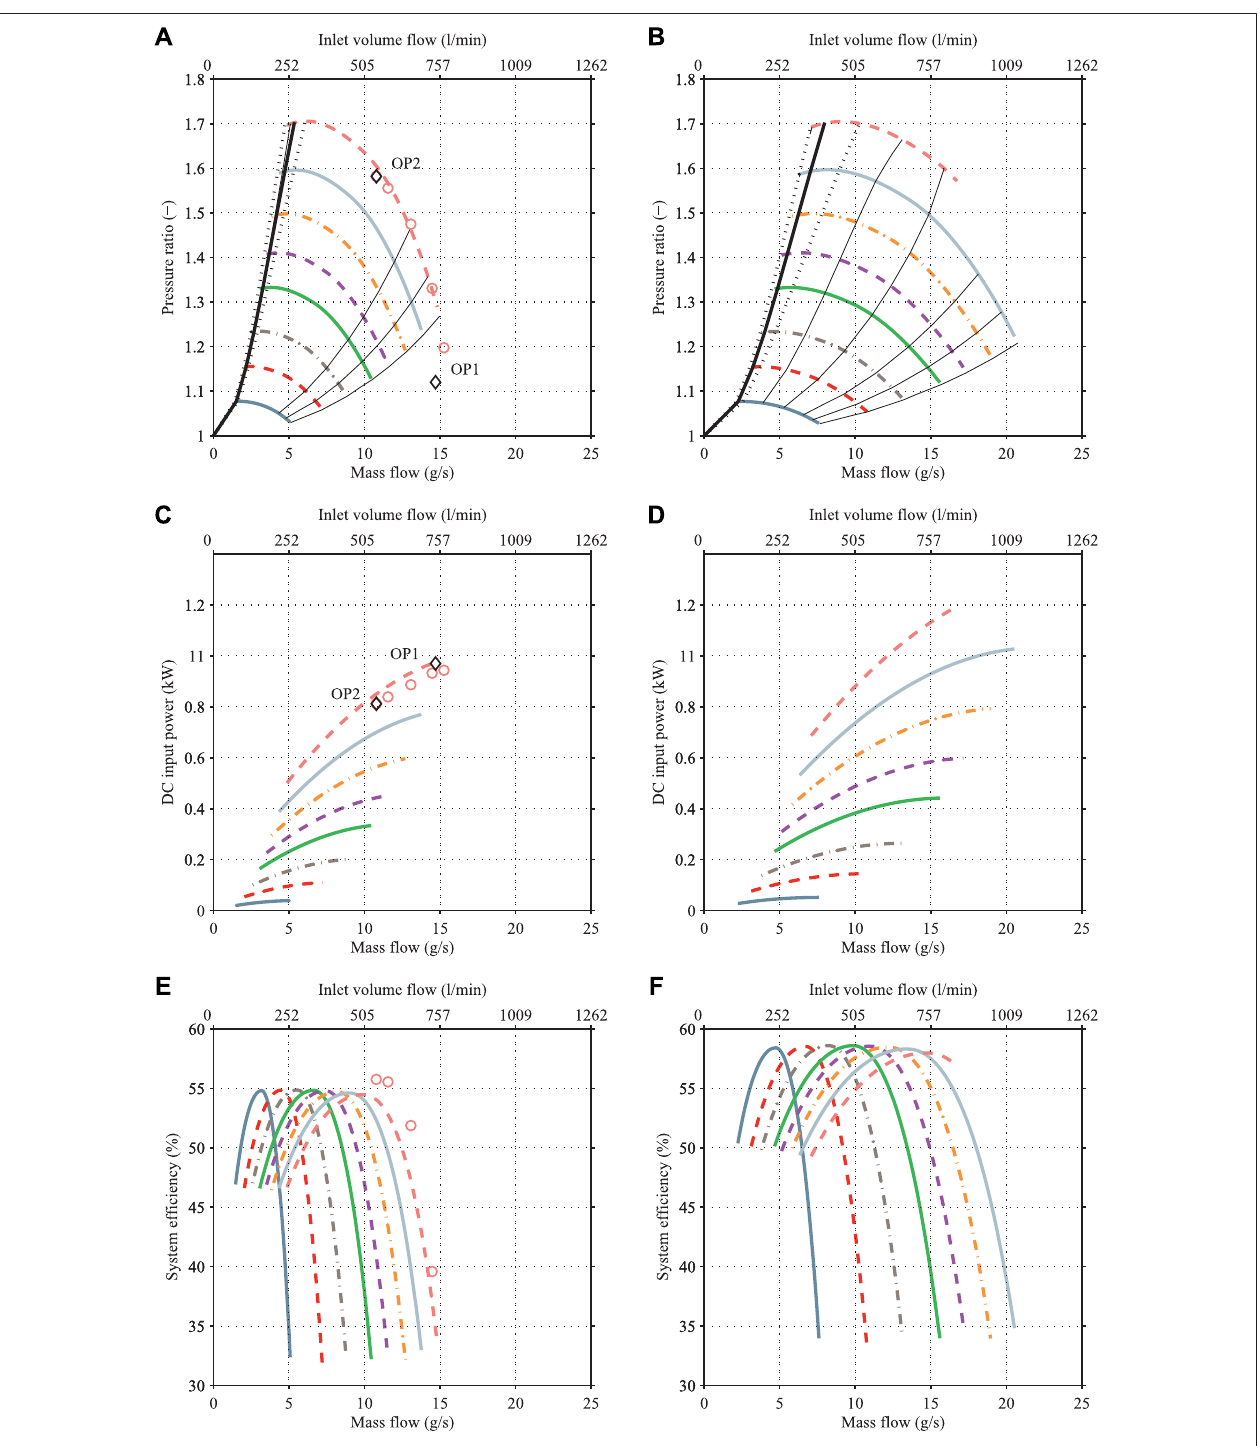
FIGURE 11 | Calculated and measured performance maps of the compressor with integrated inverter and aerodynamic design of the CT-17-700 GB compressor (A, C, E) and with the aerodynamic design of the CT-17 – 1000 GB compressor (B, D, F) . The pressure ratio maps are shown in (A, B) , the power maps in (C, D) , and the ef fi ciency maps in (E, F) . Measurement results are visualized by circles. The black diamonds show the operating conditions of the temperature measurements, summarized in Table 4 .